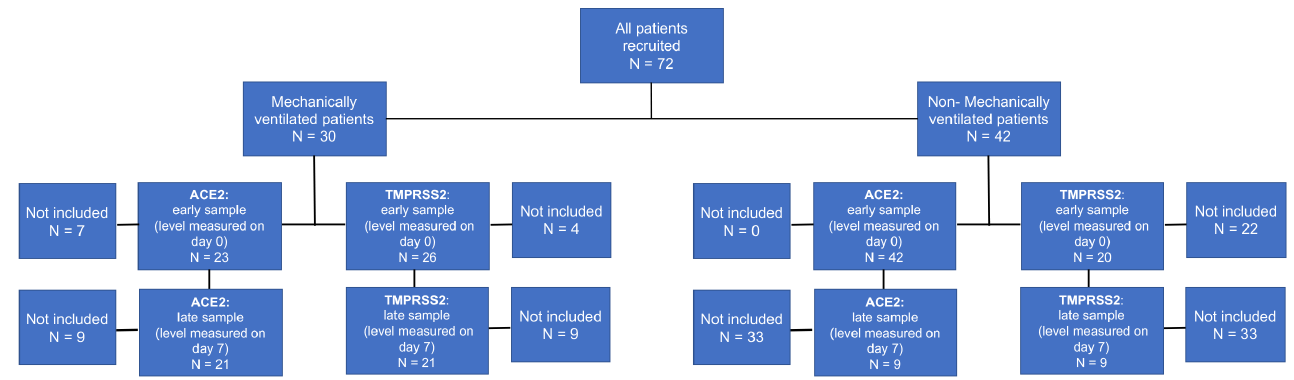
Figure 1. Flow chart of COVID-19 patients recruited for the study. ACE2, Angiotensin converting enzyme 2; TMPRSS2, transmembrane serine protease 2.